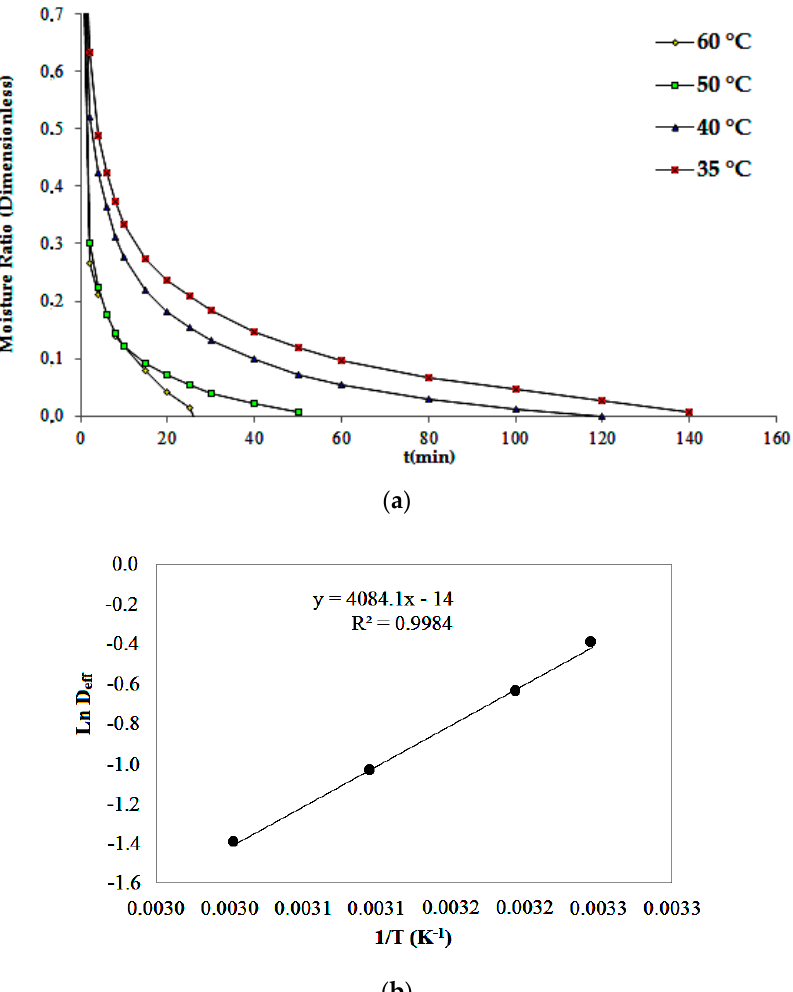
Figure 1. Kinetic drying curves of Jambu leaves at di ff erent temperatures ( a ) and natural logarithm of e ff ective di ff usivity (D e ff ) as a function of drying air of the inverse of temperature ( b ).